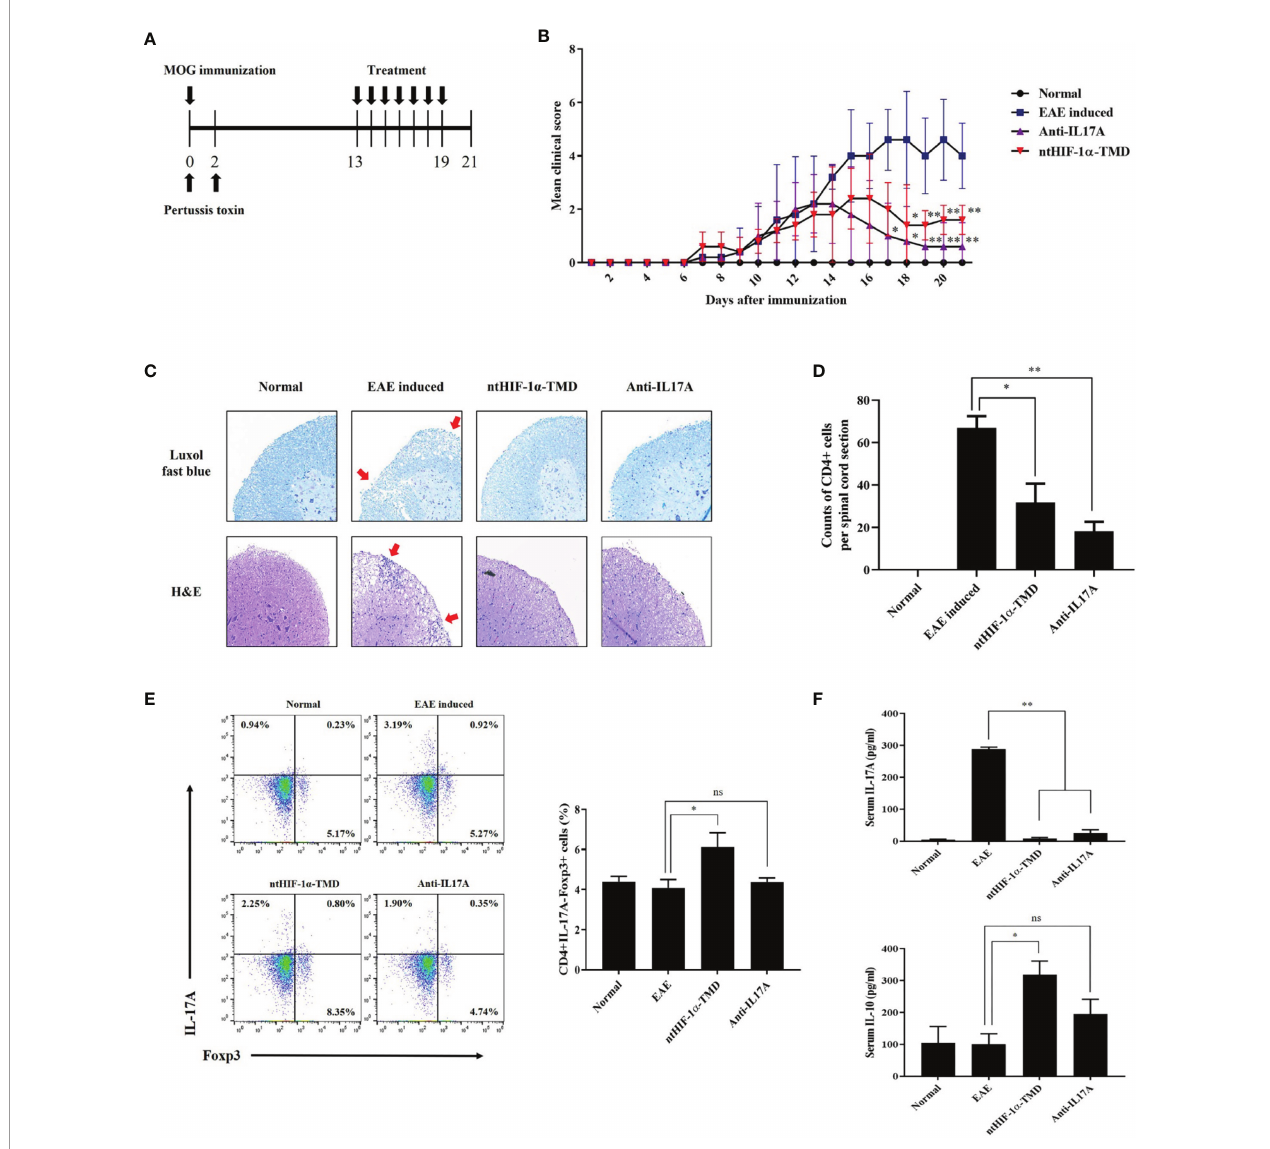
FIGURE 4 | Therapeutic potential of ntHIF-1 a -TMD in EAE disease models. (A) The treatment scheme of EAE-induced mice with phosphate-buffered saline (EAE induced), ntHIF-1 a -TMD (100 m g/mouse), or anti-IL17A (40 m g/mouse) is represented. (B) A clinical score was measured until 21 days after EAE induction. (C) EAE-induced mice (w/or w/o treatment) were sacri fi ced 16 days after EAE induction. The spinal cords were harvested, and the histological analysis was performed by Luxol Fast Blue (C , upper panel ) and H&E (C , lower panel ) staining. (D) CD4+ T cells in fi ltrated into the spinal cord in (C) were counted, and the graph is represented as mean ± SEM ( n ≥ 4). (E) CD4+ T cells in the lymph nodes harvested from the mice at day 16 were analyzed for the expression of IL-17A or Fopx3 by fl ow cytometry. (F) The level of IL-17A or IL-10 in the serum of mice at day 16 was measured by ELISA. The graphs are represented as mean ± SEM ( n ≥ 3). The experiments in EAE disease model were independently performed three times. The group differences were analyzed by Student ’ s t -test as a statistical analysis. ns, not signi fi cant, *P < 0.05, **P <